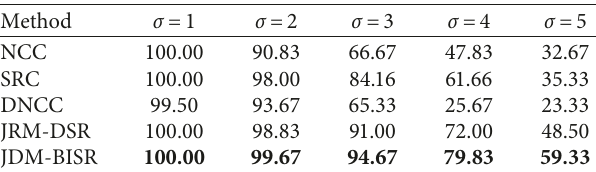
Table 8: Image matching results comparison in terms of the standard deviation of Gaussian blur kernel, where the results are the accuracy for PD ≤ 5.